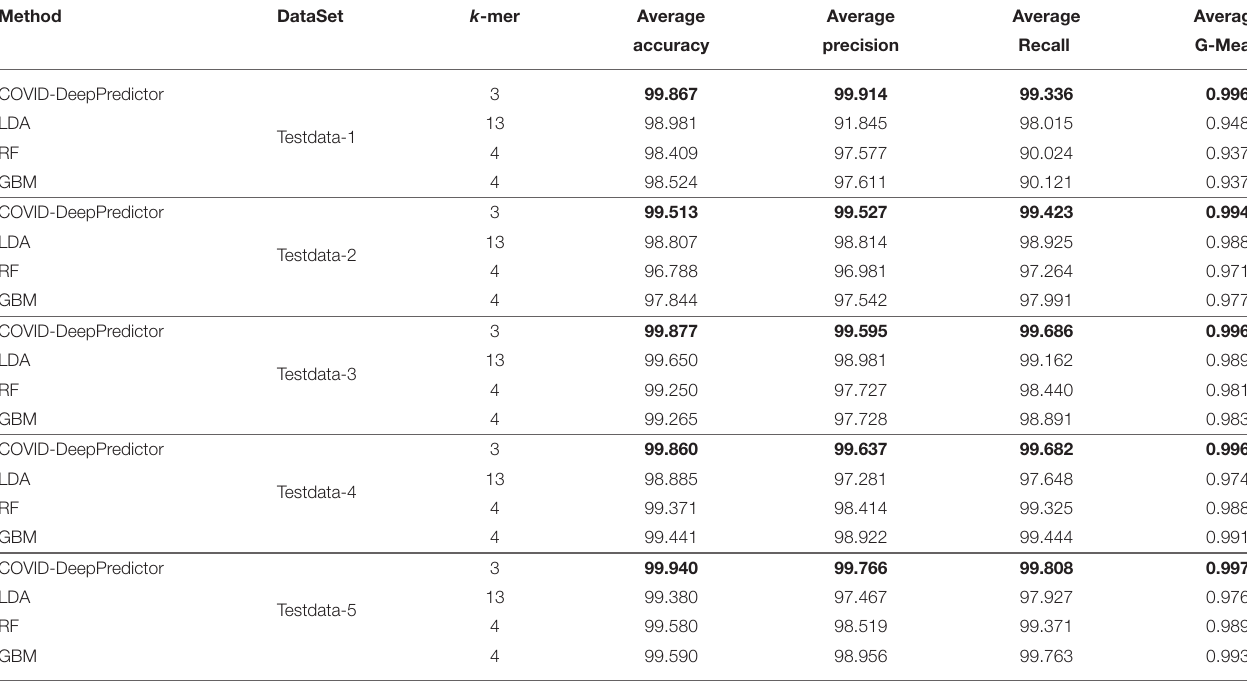
TABLE 2 | Prediction performance of COVID-DeepPredictor and other compared methods on test